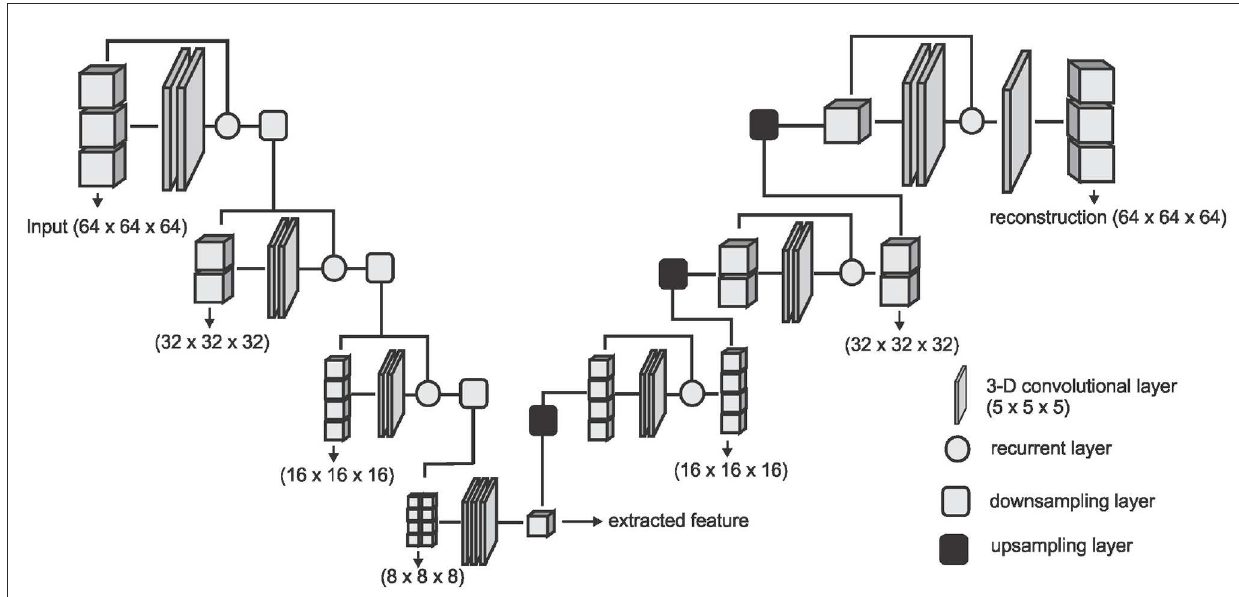
FIGURE2 The network architecture used for extracting the DAE features. The downsampling layer is a convolution with a stride of (2 × 2 × 2) which downsamples the input volume to half of the size on every axes. The upsampling layer is a transposed convolution with a stride of (2 × 2 × 2) which doubles the size of the input on every